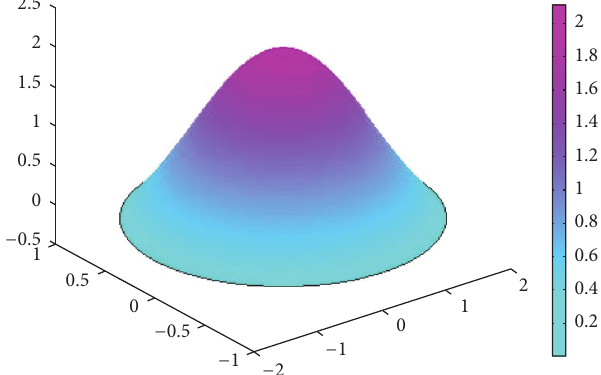
Figure 5: Stress function Ψ 2 ; 𝑎 = 2 , 𝑏 = 1 ; 𝑘 1 = 𝑘 3 = 1 , 𝑘 2 = 𝑐 = 2 . Color spectrum: Ψ 2 .